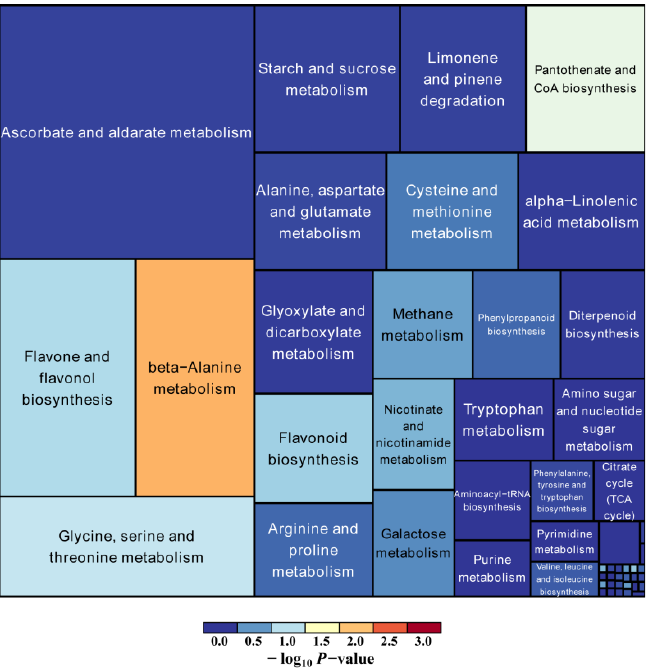
Figure 7. Heat map of the top 55 down-regulated metabolites. Pathway analysis for petals vs. stigmas. One metabolic pathway was represented by one rectangular in the diagram. The sizes indicate the influencing factor of the pathway in the topology analysis, with a larger size showing a larger degree of the influencing factor. The colors represent the p values (negative natural logarithm, − ln( p )) of the enrichment analysis, with darker colors showing a higher degree of enrichment.